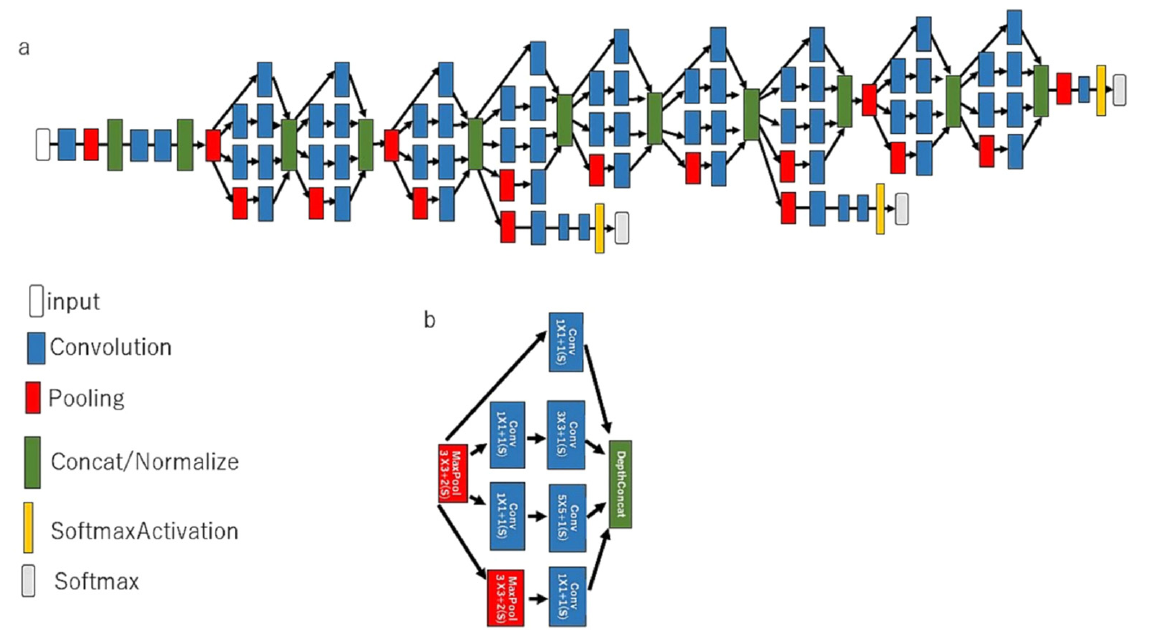
Figure 1. The architecture of a CNN model in GoogLeNet. The pretrained CNN comprises a 22-layer DNN, both ( a ) implemented with a novel element dubbed an inception module and ( b ) implemented with batch normalization, image distortion, and RMSprop, including a total of 4 million parameters.